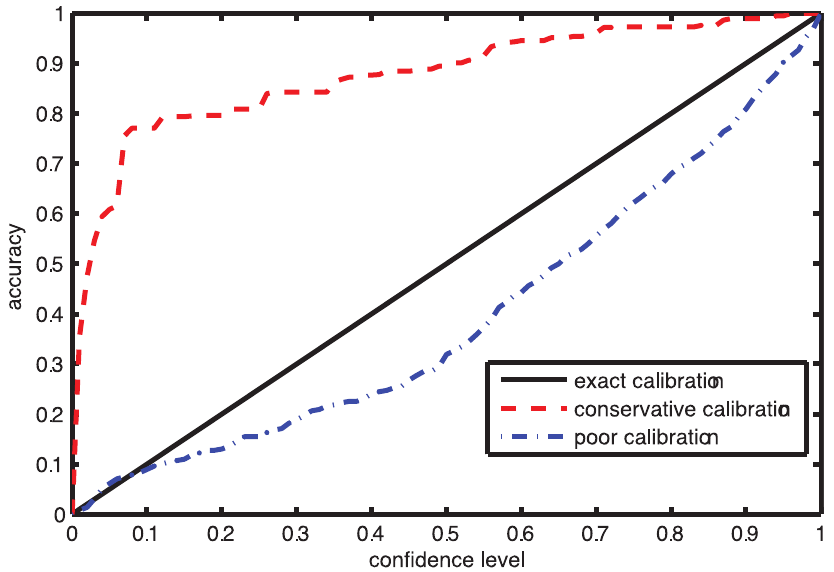
Figure 1. An illustrative example of calibration property.